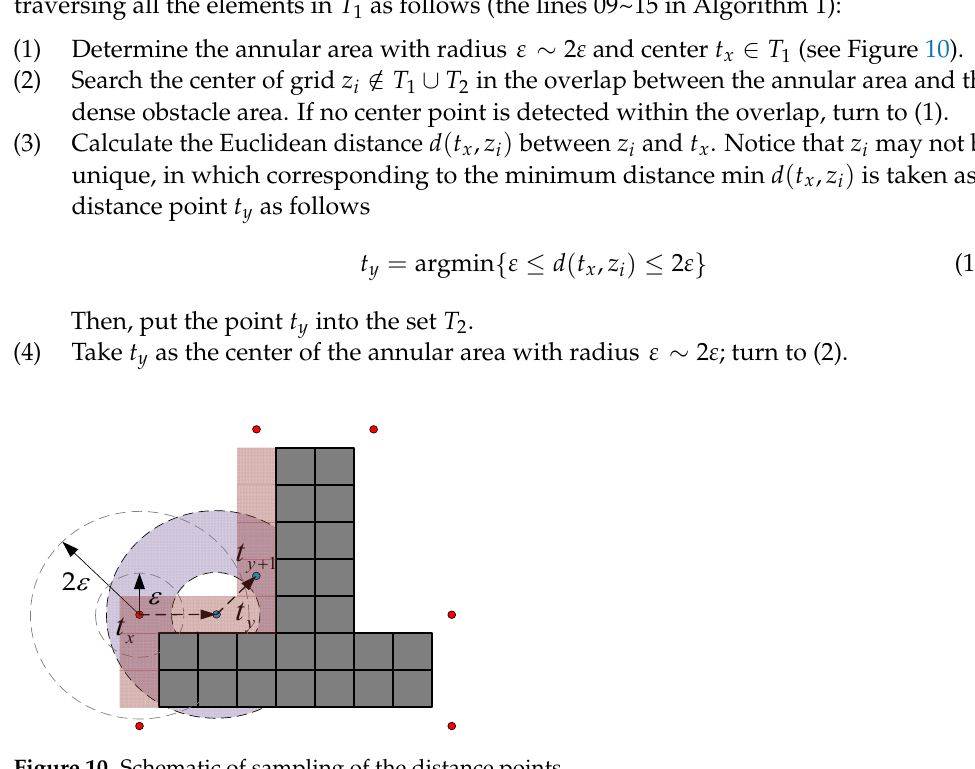
Figure 10. Schematic of sampling of the distance points. Algorithm 1: Sampling Points